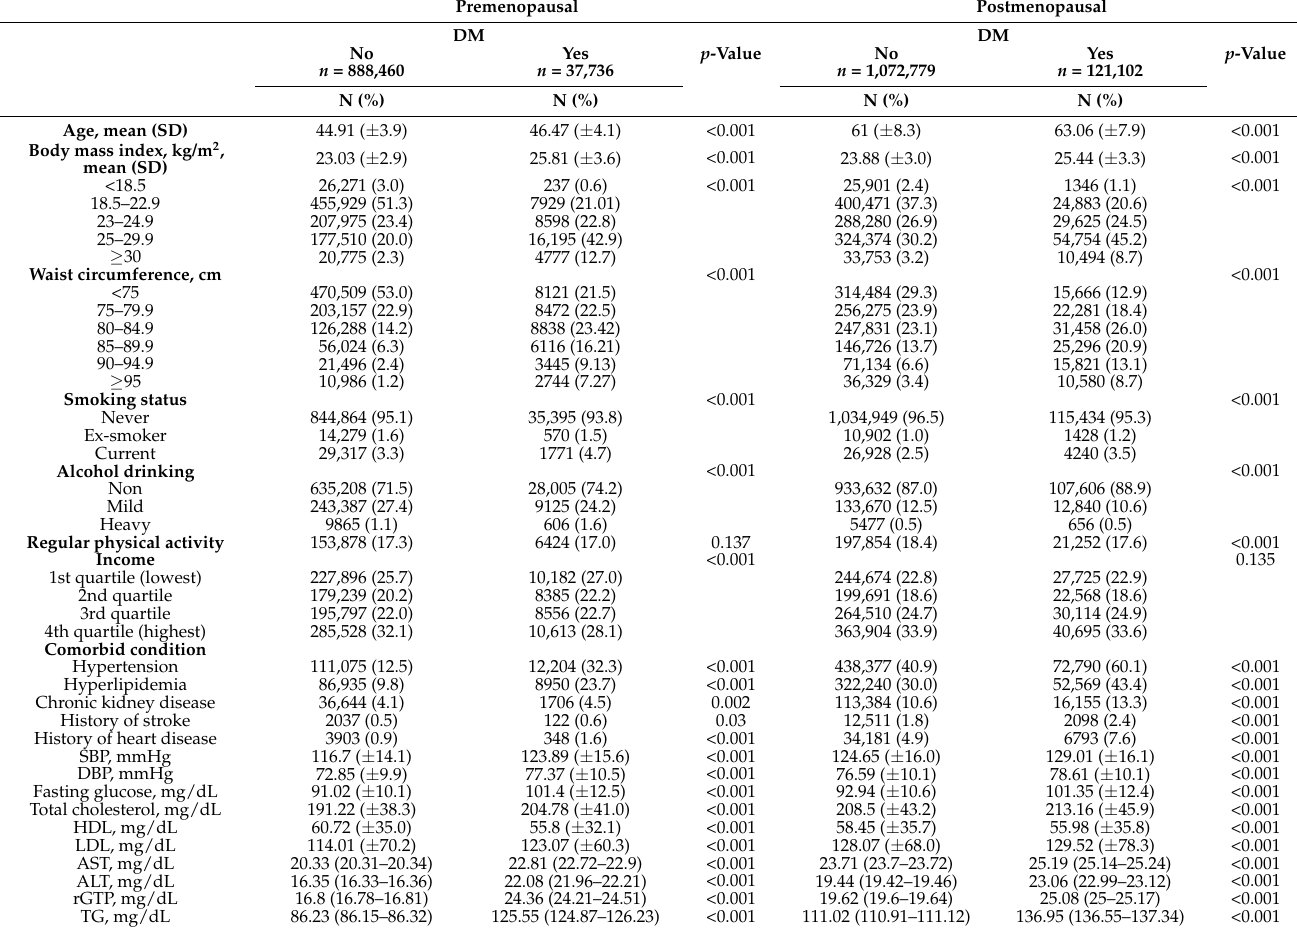
Table 1. Baseline characteristics of the study population according to menopausal